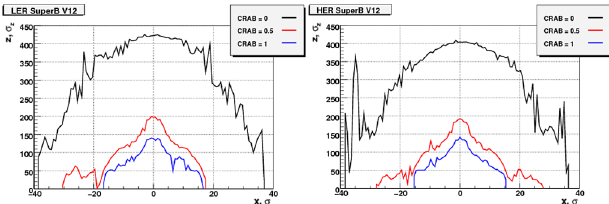
FIG. 8. On momentum dynamic aperture of SuperB LER and HER: black line — crab sextupoles are off, red and blue — crab sextupoles strength of 50% and 100% of nominal